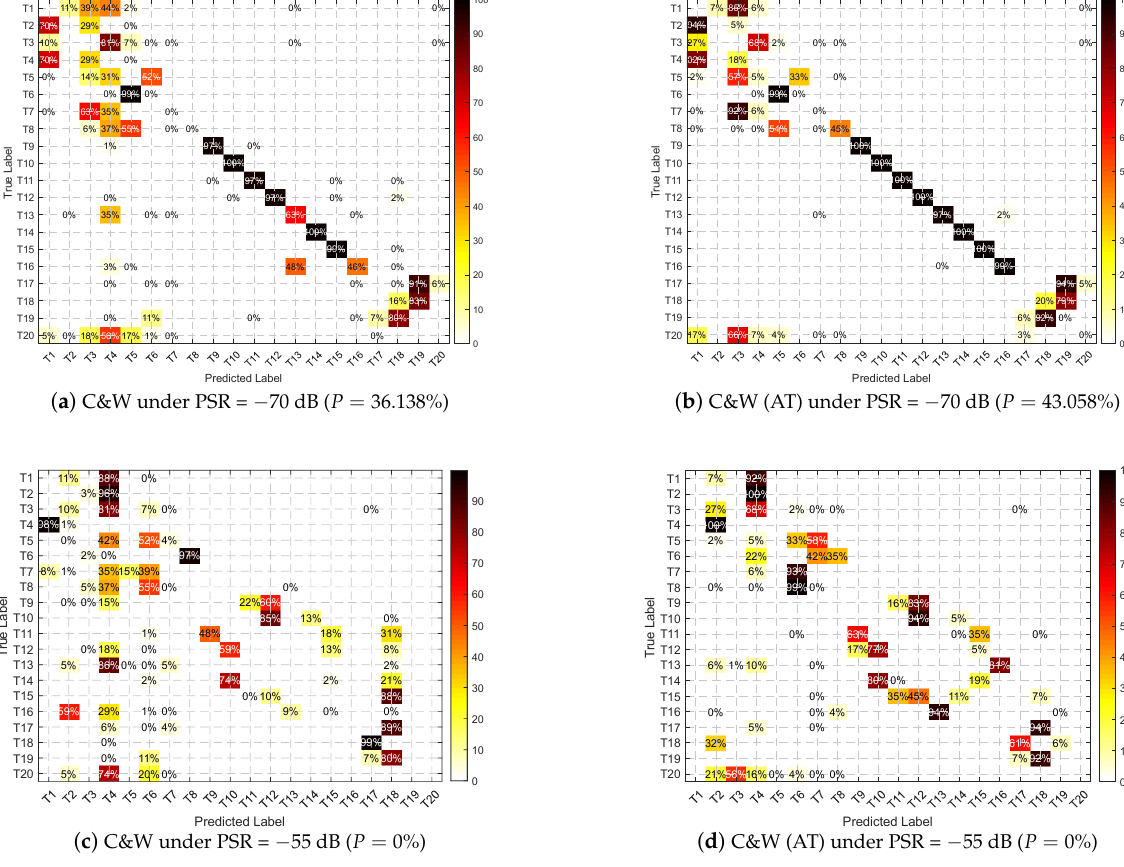
Figure 20. Recognition effect of the system with and without AT under C&W attack when SNR = 35 dB for Dataset 2.